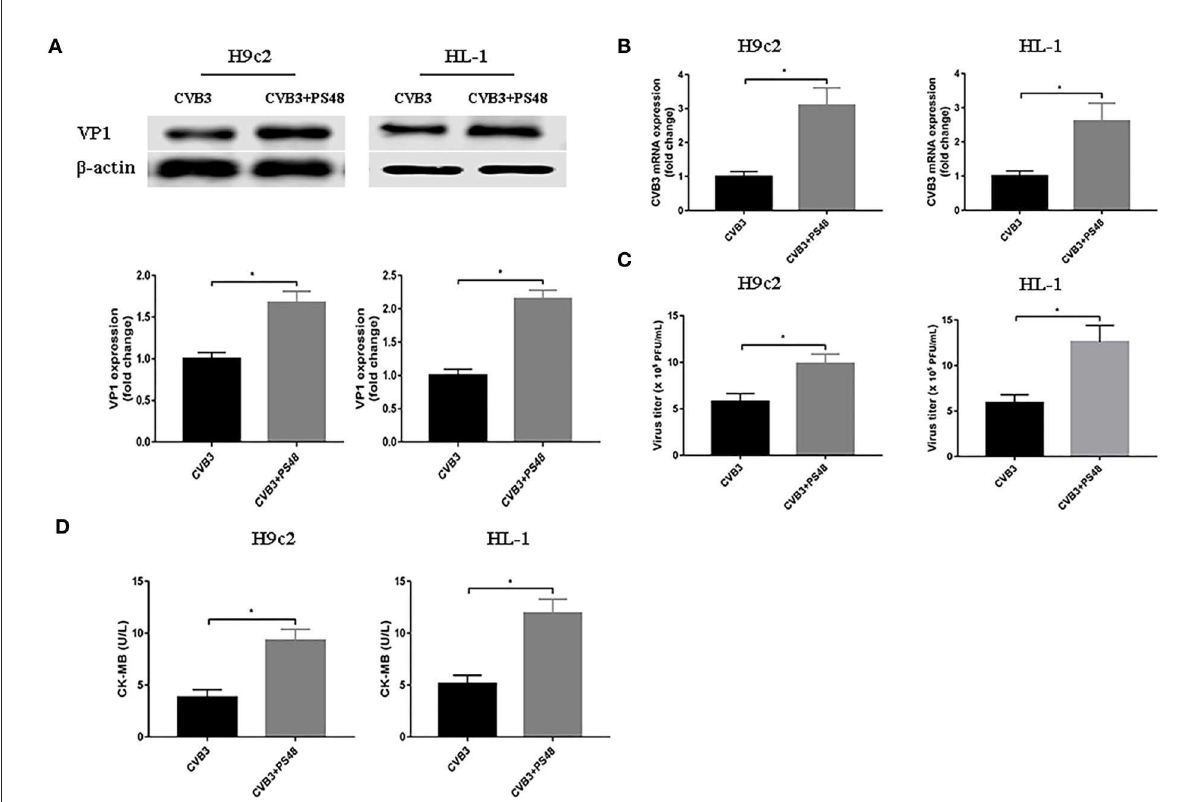
FIGURE3 Glycolysis enhancer promotes coxsackievirus B3 replication. H9c2 and HL-1 cells were infected with coxsackievirus B3 at a multiplicity of infection of 10, with or without simultaneous PS48 (10mM) treatment. Cells were harvested at 24h post-infection, and the intracellular VP1 level was measured by Western blotting (A) , and viral RNA was measured by quantitative PCR (B) . Cell supernatants were harvested at 24h post-infection, viral titer levels were measured by plaque-forming unit assay (C) , and creatine kinase-MB levels were tested (D) . Data are indicated as mean ± SEM; Data represent three independent experiments, with three technical replicates per experiment; * P <